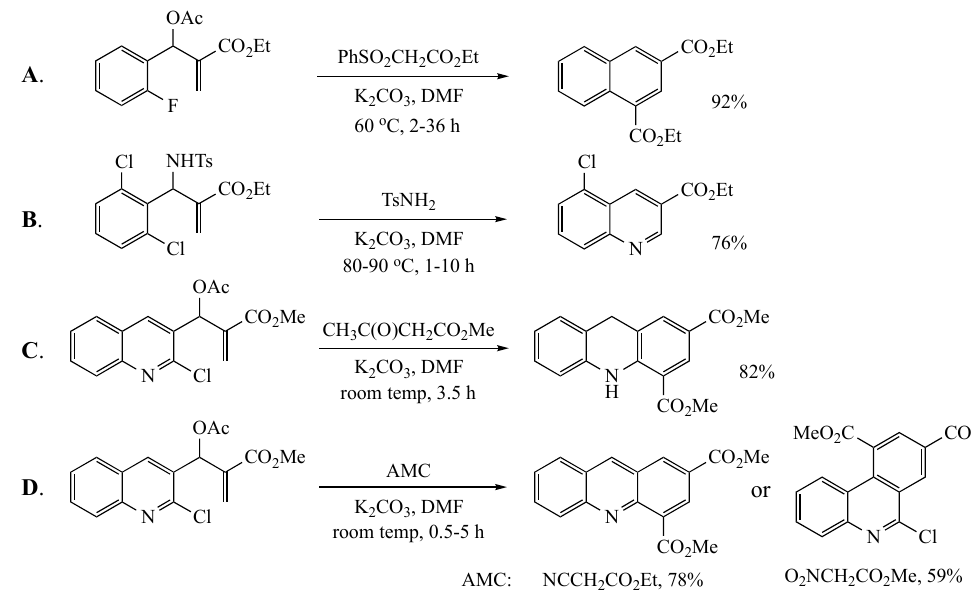
Figure 1. Previous cyclizations to generate aromatic systems using Morita–Baylis–Hillman (MBH) acetates. ( A ): Formation of naphthalenes; ( B ): Formation of quinolines; ( C ): Formation of dihydroacridines; ( D ): Formation of acridines and phenanthridines.